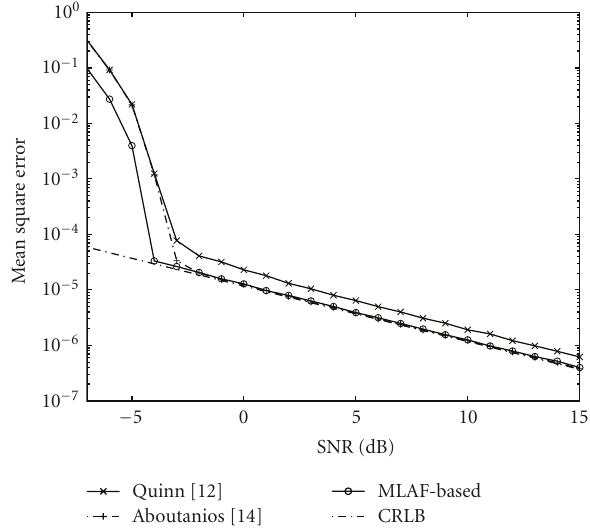
Figure 5: Comparison with periodogram-based estimators. Signal frequency randomly distributes between [0,0 . 5 π ]. N = 80. For the MLAF-based estimator, q = 4 and τ = 1.